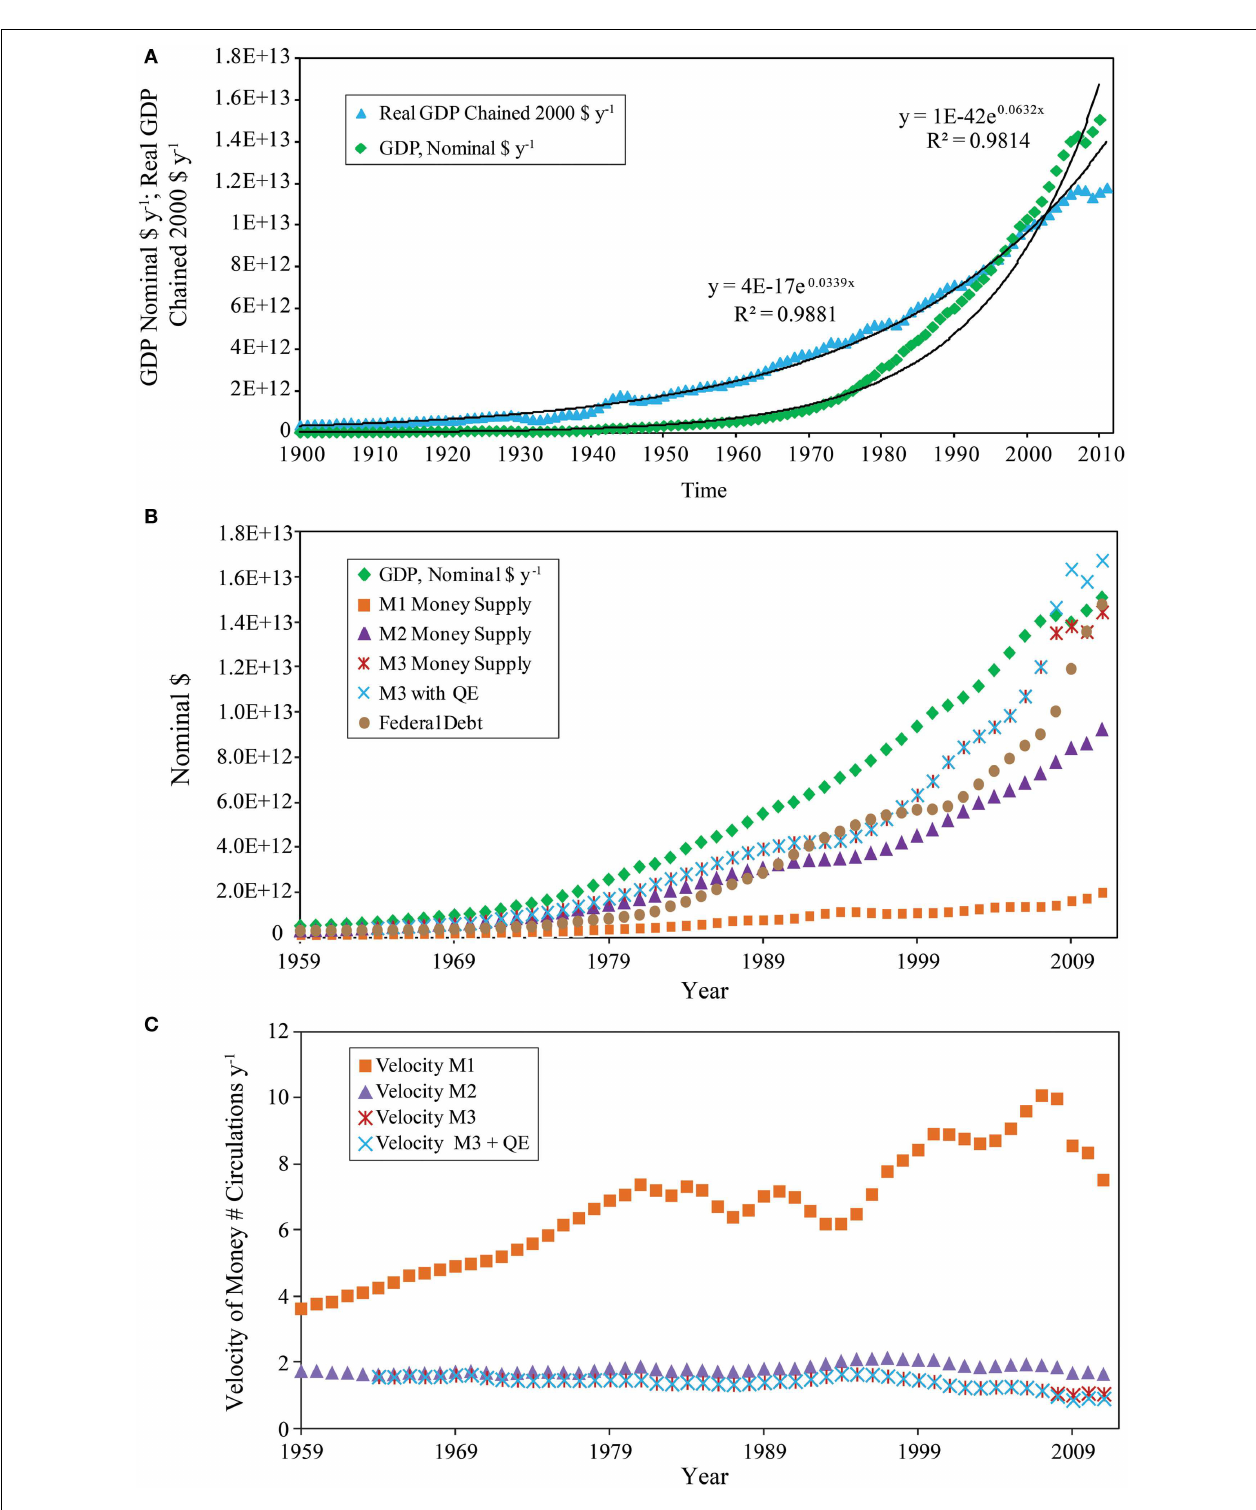
FIGURE 8 |Temporal patterns of money flow and money supply in the U.S. economy, 1900–2011 are shown . (A) Money flow as measured by nominal GDP and real GDP in 2000 chained $; (B) money supplies; M1, M2, M3, M3 plus QE shown with Nominal GDP and the Federal Debt for comparison. (C) Velocity of money in the number of circulations per